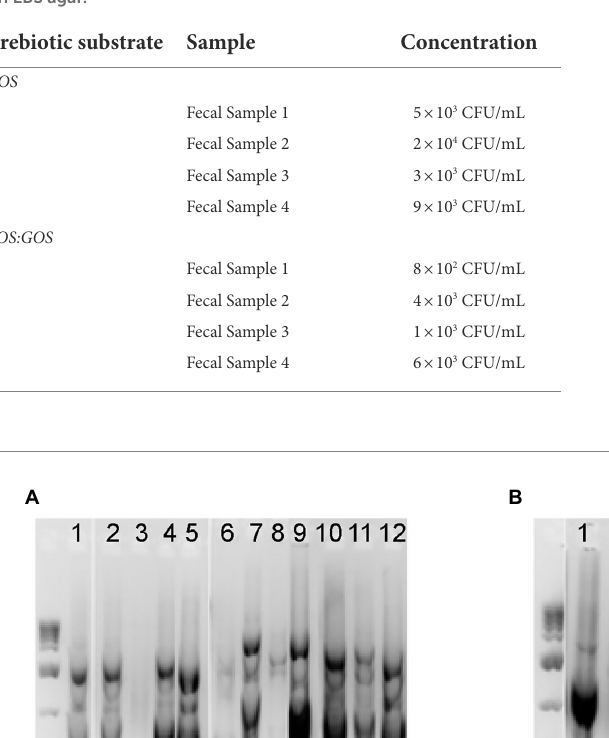
TABLE 3 Levels of potential Lactobacillaceae after in vitro fecal culture in the presence of prebiotic determined by selective plating on LBS agar.